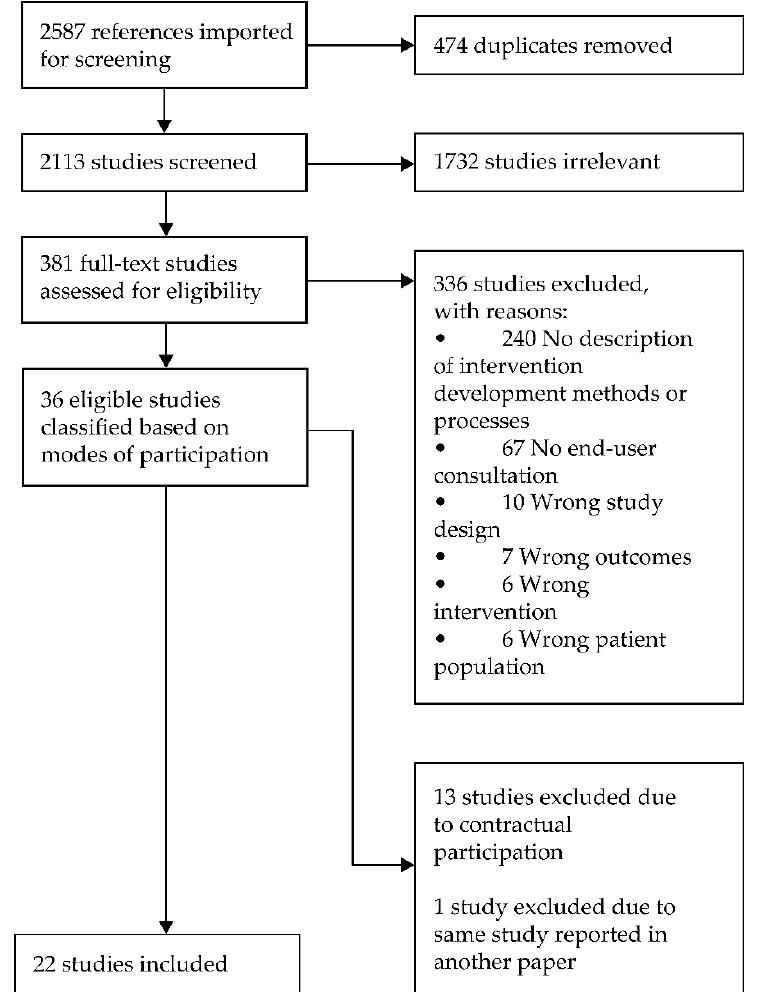
Figure 1. Identification and selection of studies.